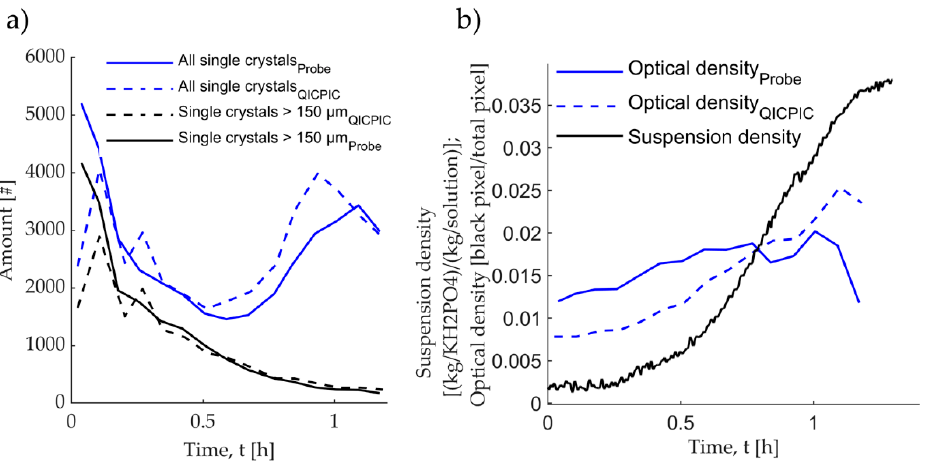
Figure A4. ( a ) Quantity of single crystals analyzed ( b ) the optical and suspension densities during experiment Exp. 1—KH 2 PO 4 .